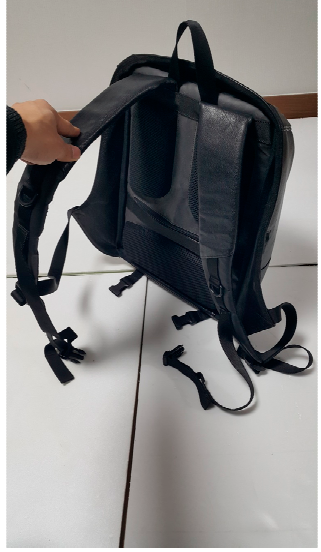
Figure 1. Backpack of typical design. Int. J. Environ. Res. Public Health 2019 , 16 , x